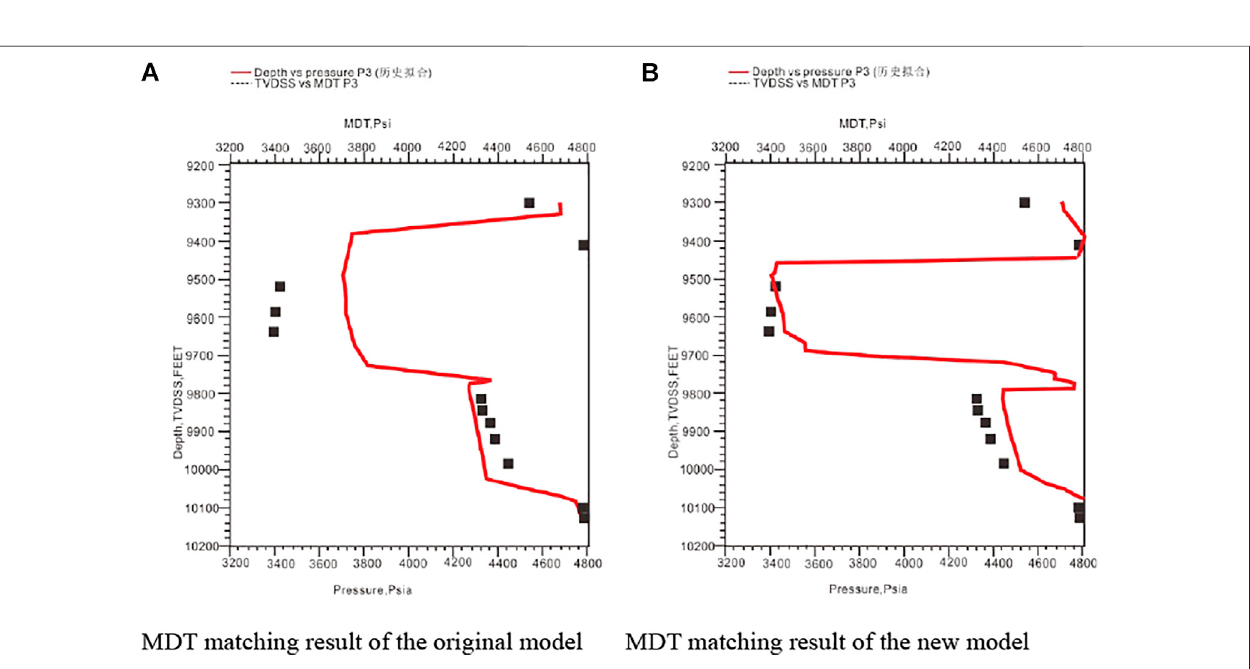
Frontiers in Energy Research |